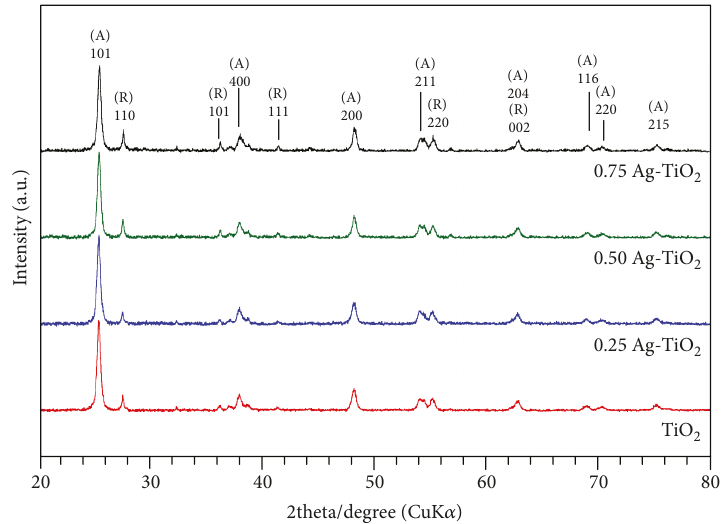
Figure 1: XRD patterns of nano-Ag-TiO